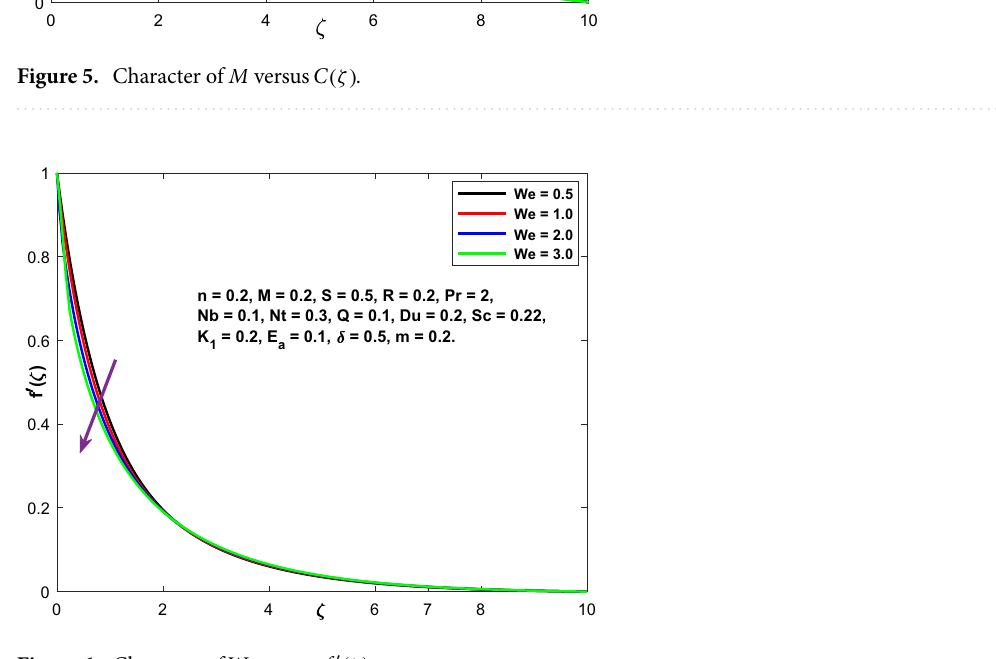
Figure 6. Character of We versus f ′ (ζ)